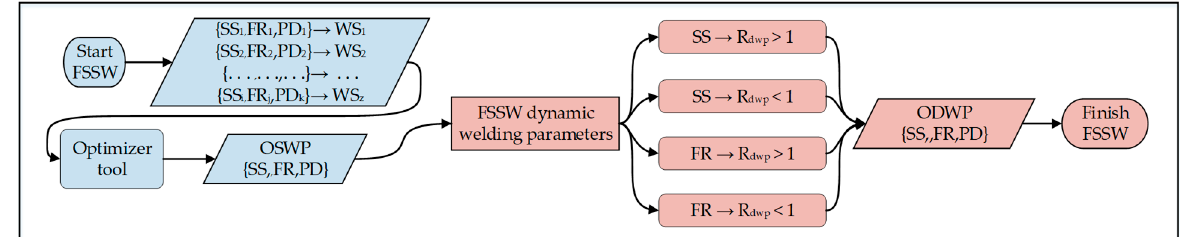
Figure 3. Research framework.